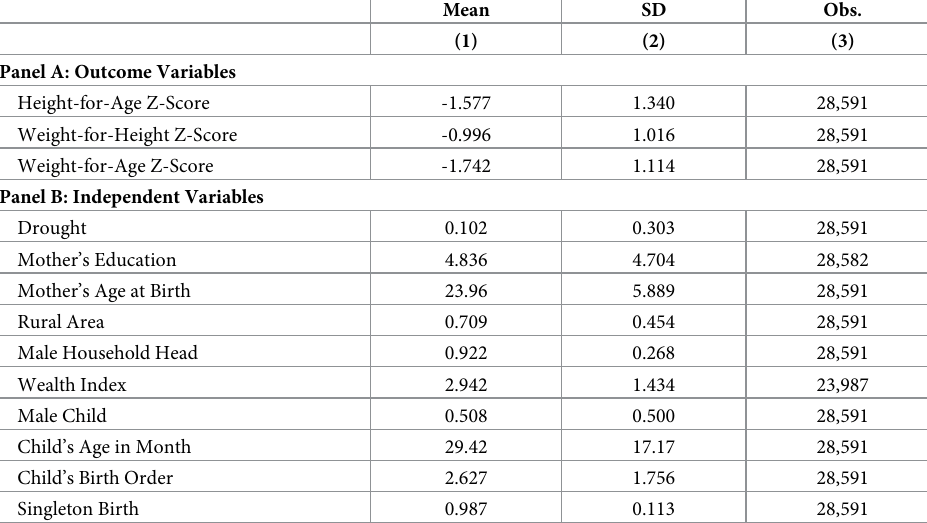
Table 2. Summary